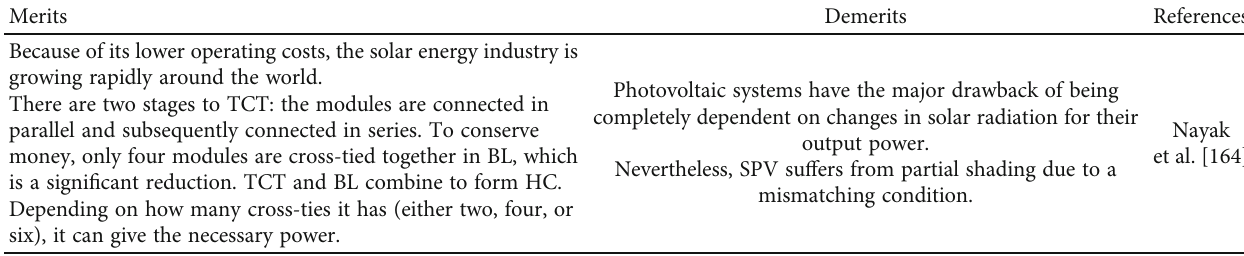
Table 7: Merits and demerits of the photovoltaic